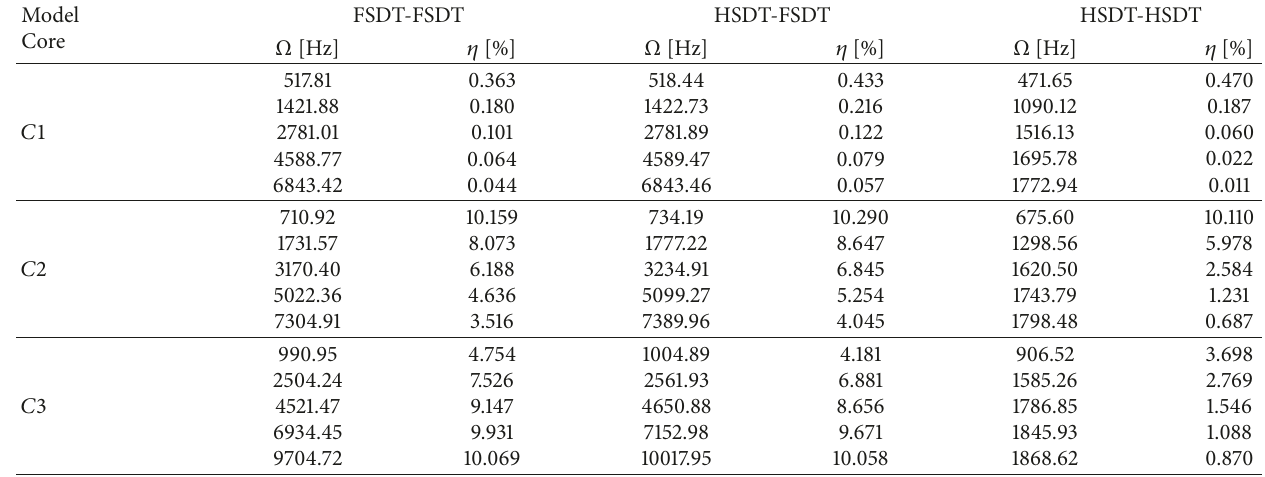
Table 12: Frequencies Ω and loss factors 𝜂 . Titanium skins.